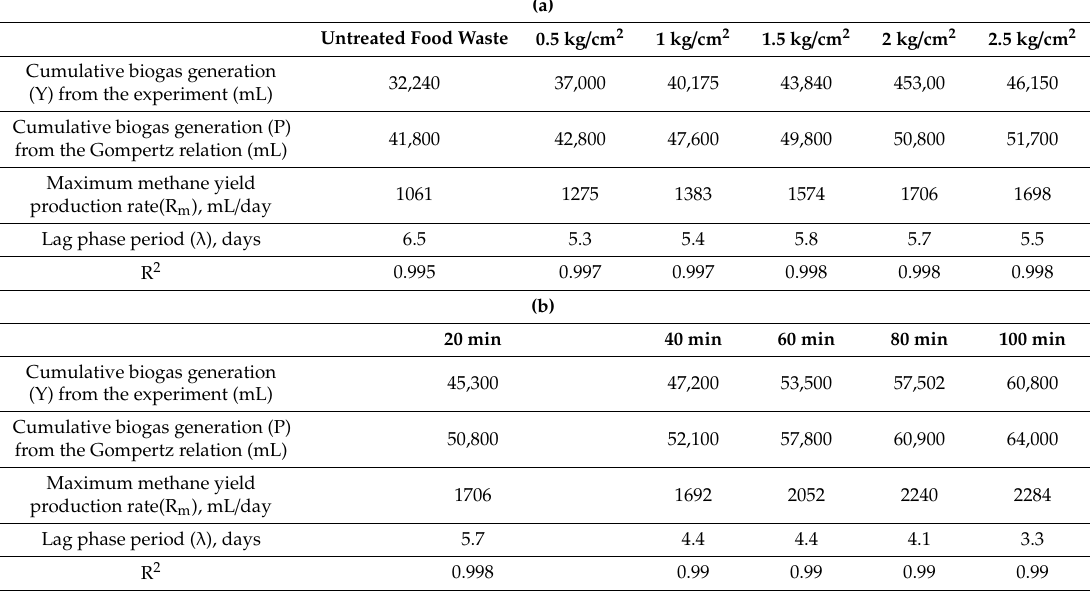
Table 5. ( a ) Parameters obtained after application of modified Gompertz equation for pretreated food waste at di ff erent pressures; ( b ) parameters obtained after application of modified Gompertz equation for pretreated food waste at di ff erent time